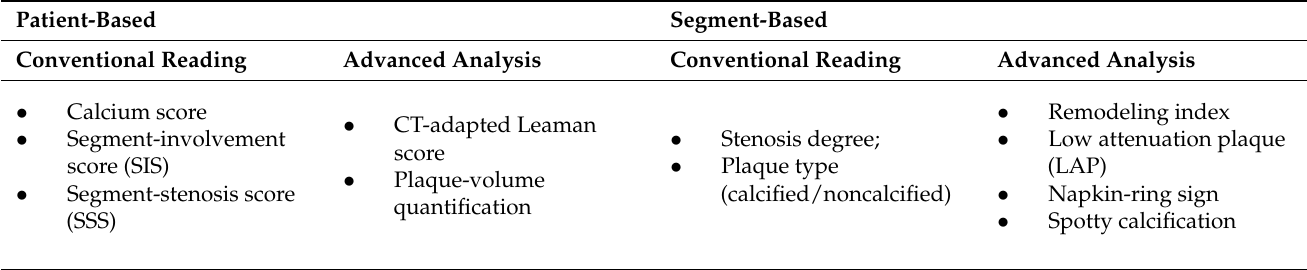
Table 2. Atherosclerosis analysis by cardiac